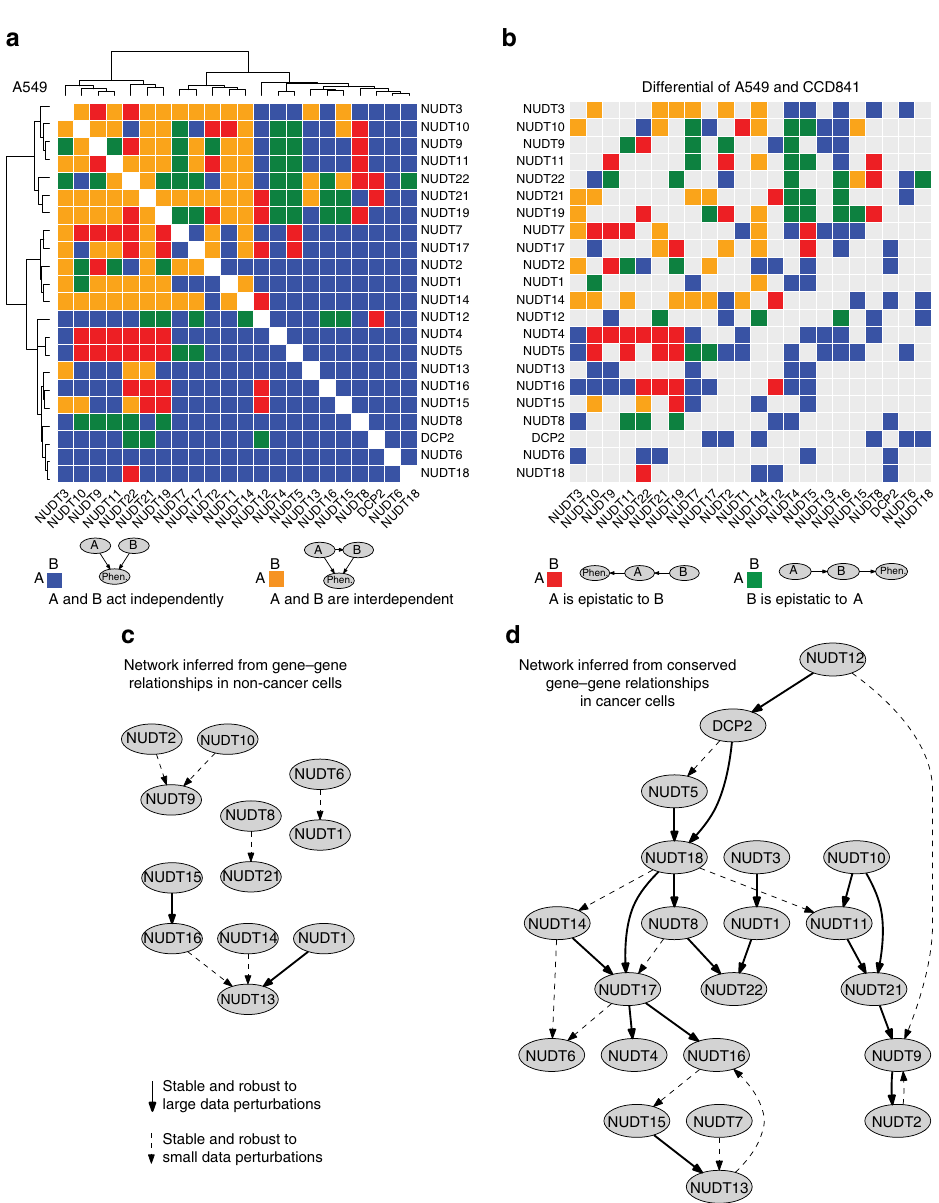
Fig. 7 Probabilistic scoring of epistatic relationships from genetic interaction data and gene network inference. a Gene – gene relationships estimated from A549 cell viability data. b Gene – gene relationships in A549 viability data that are different from those in CCD841 viability data. c Gene network inferred based on gene-gene relationships in CCD841. d Gene network inferred based on gene – gene relationships that are conserved across A549, SW480, and MCF7. Probabilities of the estimated relationships are provided in Supplementary Fig.